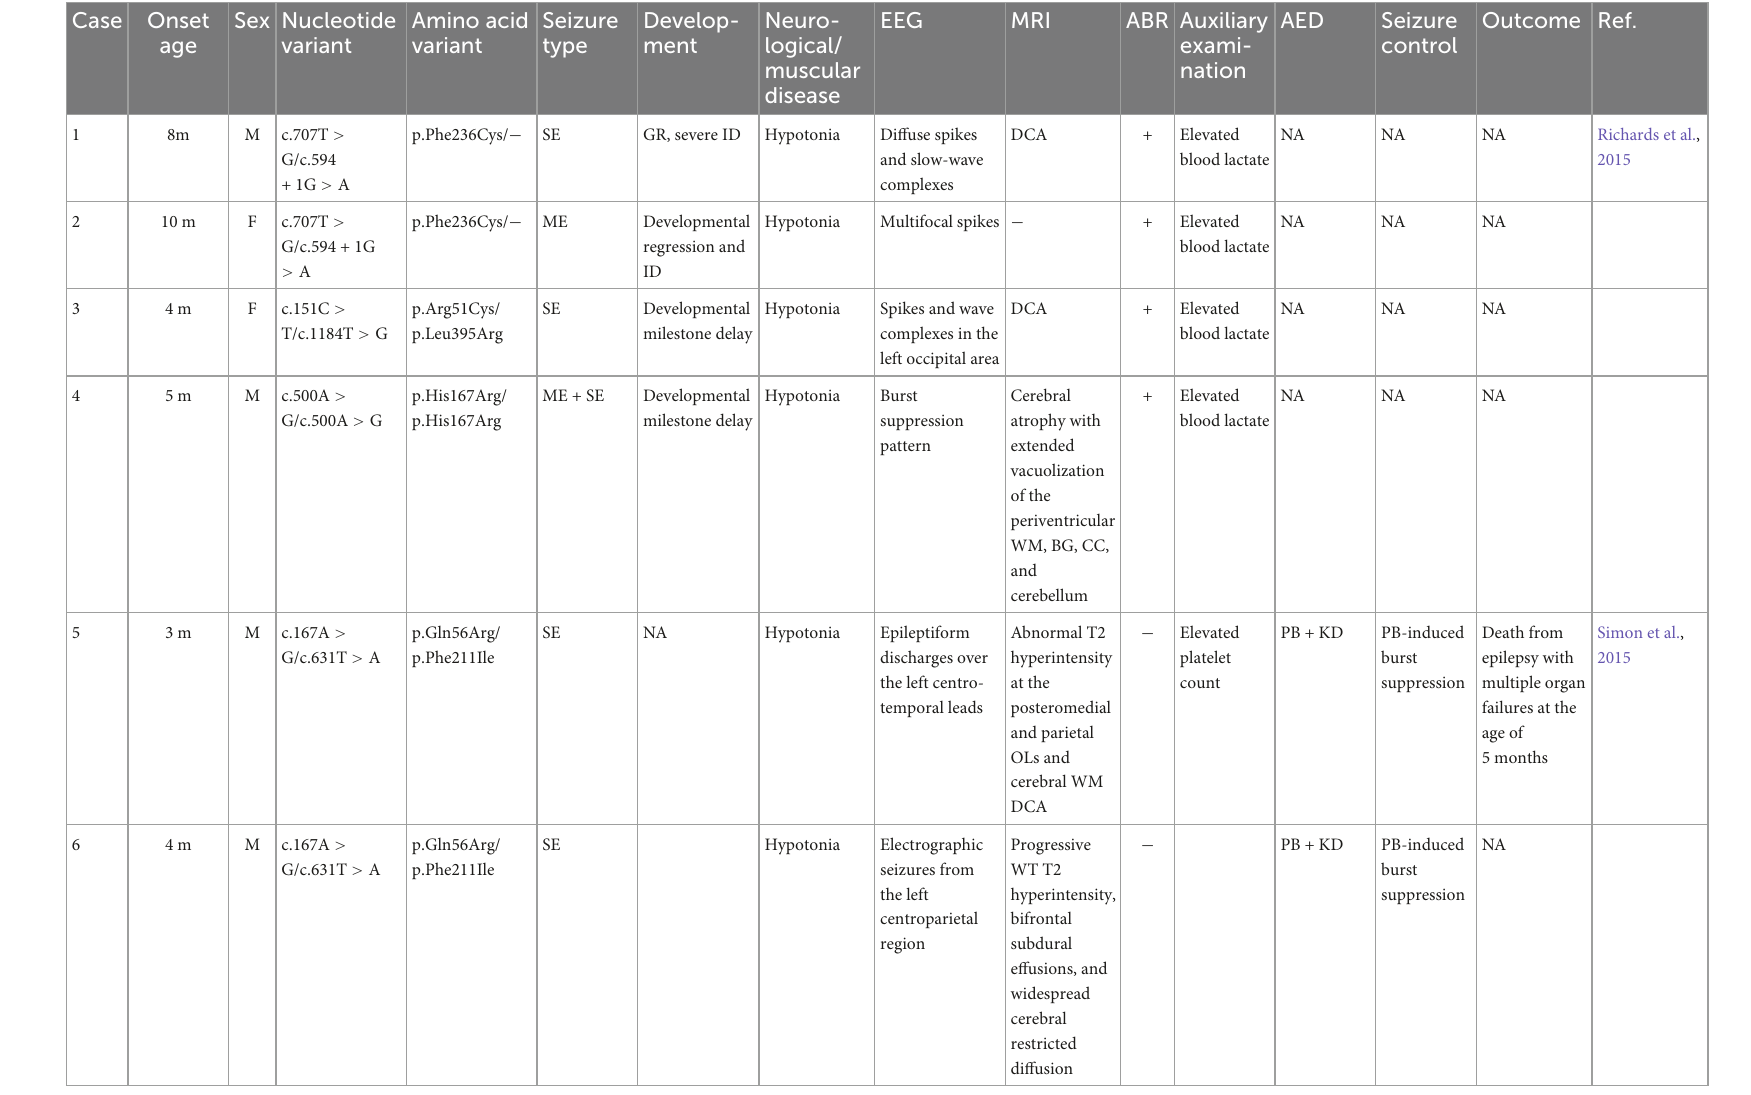
TABLE 4 Reported cases of nervous system abnormalities caused by NARS2